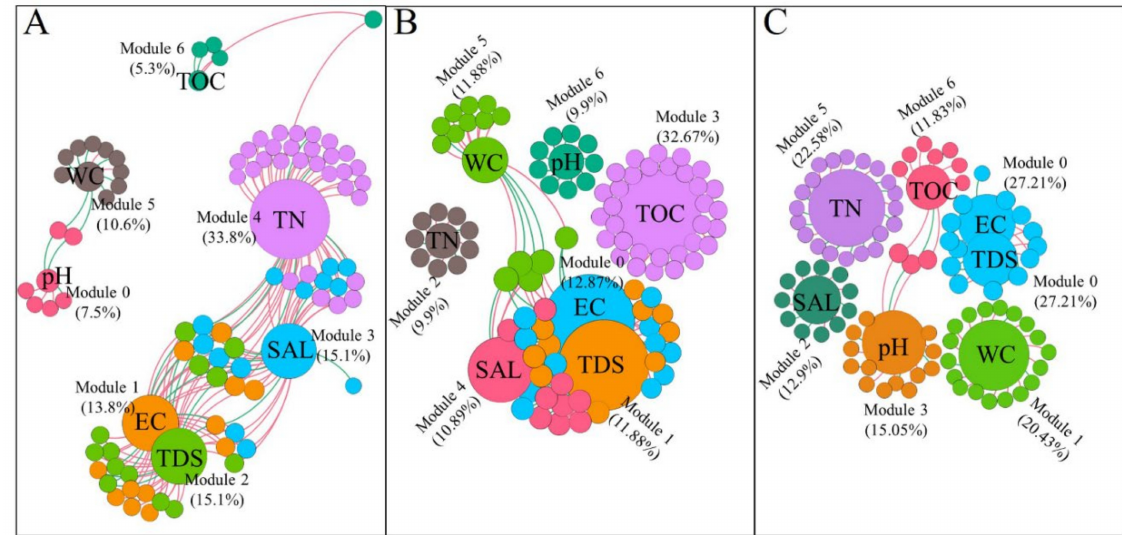
Figure 6. Co-correlations network of the bacterial communities of different habitats across three sites collected from cold-desert, Qinghai–Tibet Plateau, China, based on a correlation analysis at the genus level (relative abundance >0.01%; Spearman’s correlations adjusted p < 0.01). ( A ) The samples from site GEM, nodes 94, and edges 164. ( B ) The samples from site HLH, nodes 101, and edges 157. ( C ) The samples from site CNH, nodes 93, and edges 102. Edges characterize significantly positive (green) or negative (red) correlation. Nodes sizes correspond to their relative abundances in the data set. Genera proportions in each module are shown in Table S4. CNH—CuoNaHu, HLH—HongLiangHe, GEM—GeErMu.